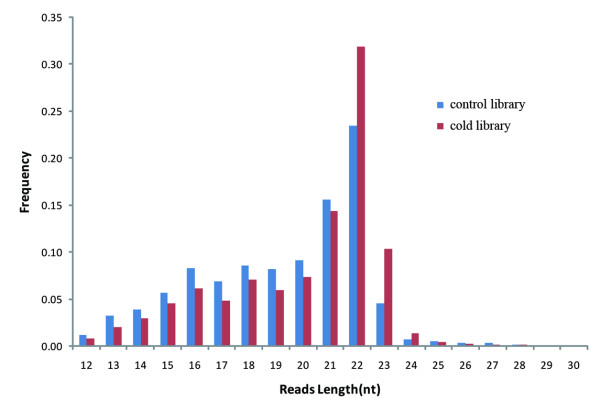
Length distribution of the high-quality reads in the 10-30 nt range.